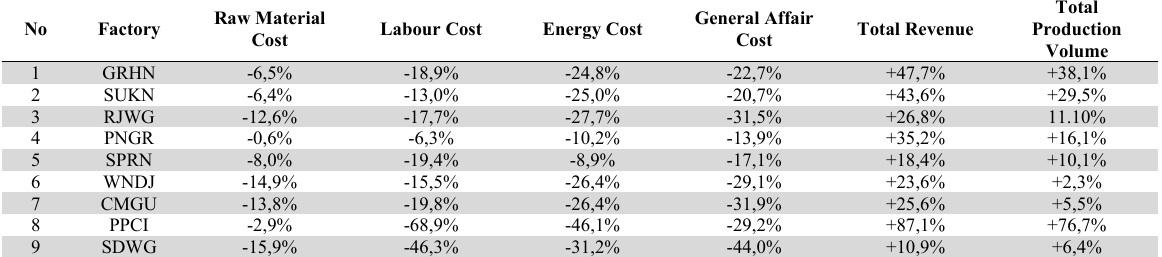
Improvement Target for Each Pine Chemical Factory per Operational Variable (Input &